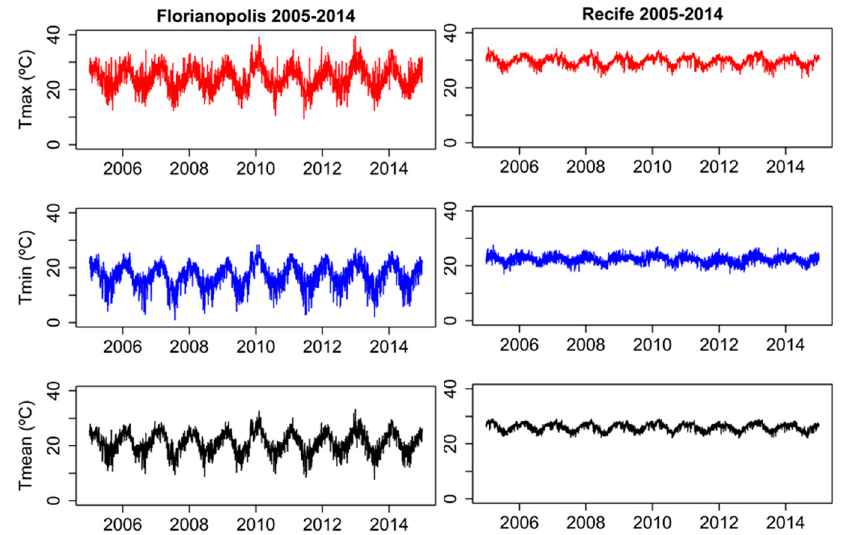
Climate 2019 , 8 , 16 Figure 2. Daily variation of maximum (Tmax, red), mean (Tmean, black) and minimum temperatures (Tmin, blue) for the health regions of Florianópolis/SC and Recife/PE for the years 2005 to 2014. The exposure-response curves over the Florianópolis health region showed a clear 'U' pattern, with a high risk of death for both high and low temperatures. It is also possible to see that cerebrovascular and cardiovascular deaths presented a higher variation in the exposure-response curves (Figure 3).